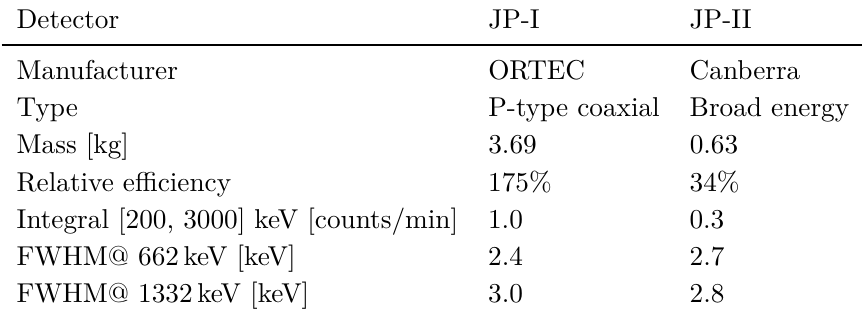
Table 2. Characteristics of the HPGe detectors.